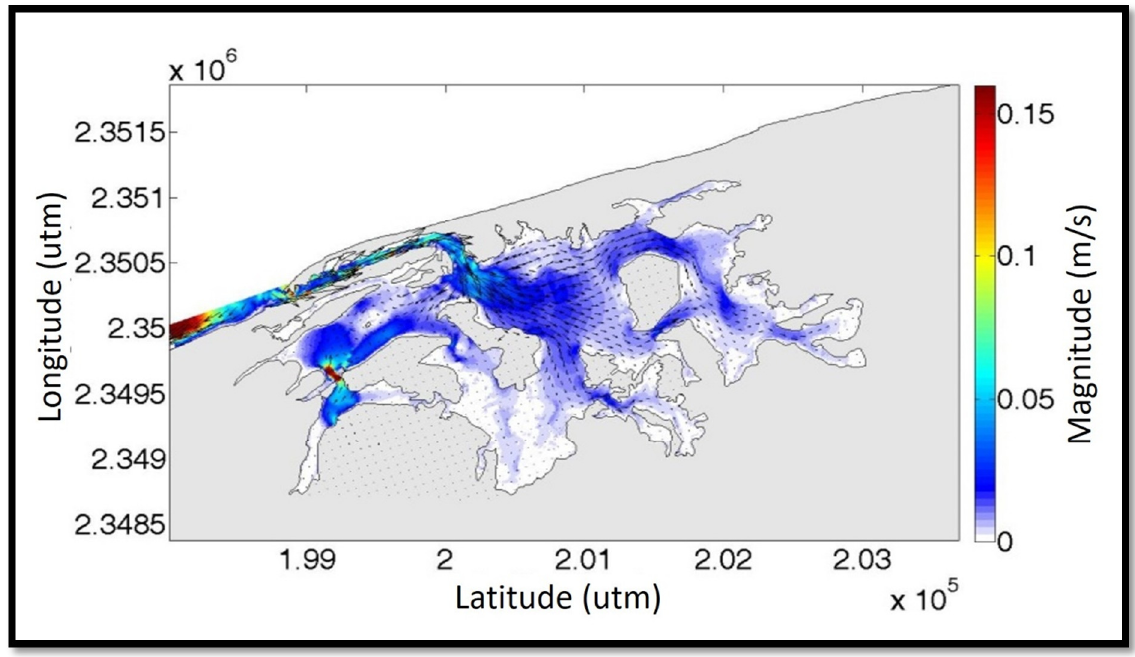
Figure A3. Example of the residual circulation pattern (m/s) during a spring tide with sea breeze forcing [33] .